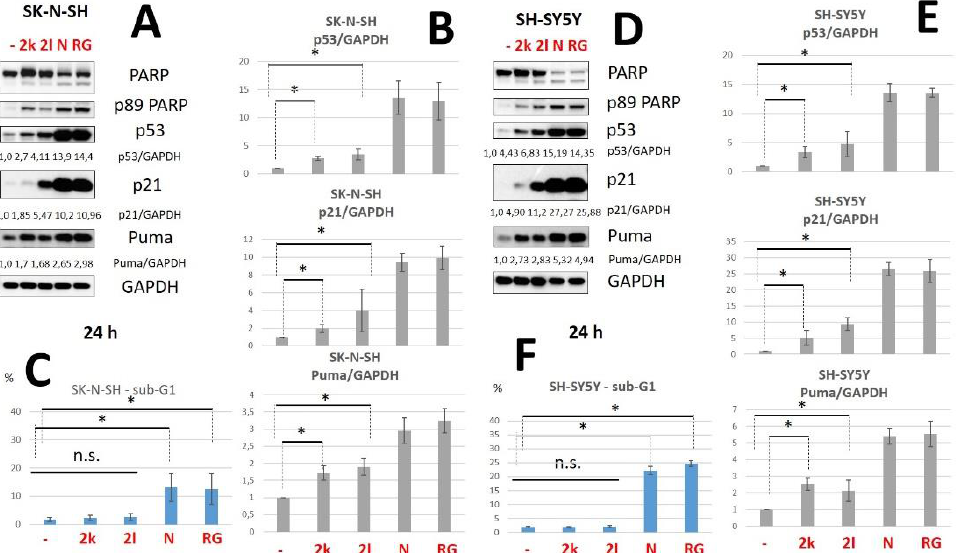
Figure 6. Western Blot analysis of total cellular lysates from SK-N-SH ( A ) and SH-SY5Y ( D ) cells upon the treatment with compounds 2l , 2k (both—20 µ M), Nutlin-3a (10 µ M) and RG7388 (5 µ M). ( B , E )— Densitometric analysis of p53, p21 and Puma bands normalized to GAPDH in SK-N-SH ( B ) and SH-SY5Y ( E ) cells. Data are presented as mean +/ − SD from three independent experiments. ( C , F )— The histogram of flow cytometry (FC) analysis data for SK-N-SH cells using sub-G1 assay, %—percent of Sub-G1 population. Data from n = 3 biological replicates are shown as mean ± s.d., * p < 0.05, n.s. — not significant. PARP — poly (ADP-ribose)-polymerase; GAPDH — glyceraldehyde 3- phosphate dehydrogenase; p53/GAPDH, p21/GAPDH and Puma/GAPDH — densitometric analysis of p53P, p21P and Puma bands normalized to GAPDH, h — hours, N — Nutlin- 3a (10 μM), R— RG7388 (5 μM).